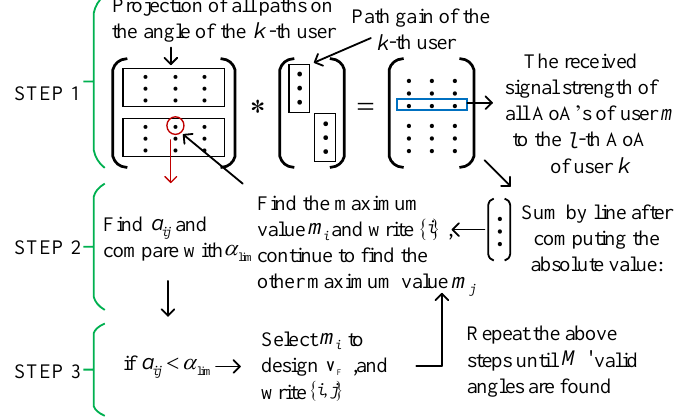
Figure 2. The procedure of the proposed angular-domain compressing based detection (ACD) algorithm.